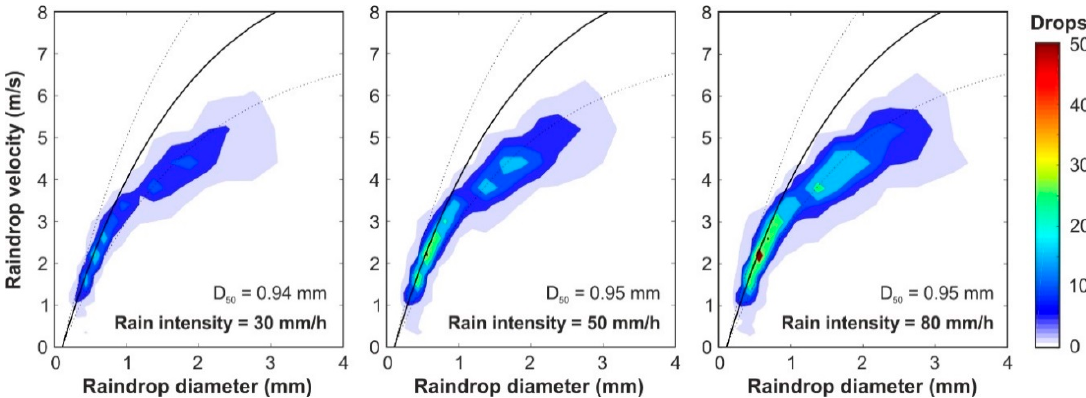
Figure 7. Number of raindrops, classified according their diameter and velocity, obtained by the disdrometer in an interval of 10 s and for the three rain intensities that it is possible to generate (30, 50 and 80 mm/h respectively). The experimental relation between diameter and terminal velocity [37] was represented by the solid and dots (±25%) curves.